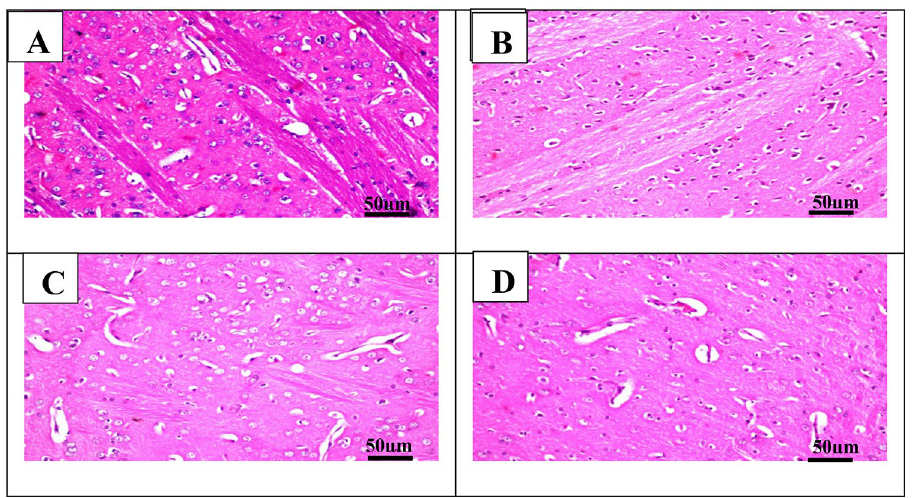
Figure 9. Representative photomicrographs (H&E, × 200) of the section from the striatum of (A) control group, (B) Cyclophosphamide group, (C) Lutein 50 group, and (D) Lutein 100 group.